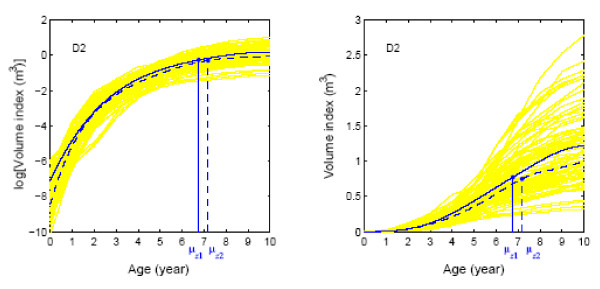
Volume growth curves for two different QTL genotypes for the QTL detected on linkage group 2 by the Legendre polynomial-based model. Left panel: log-transformed curves; Right panel: ante-transformed curves. Growth trajectories for all the individuals studied are indicated in yellow background. The effect of the detected QTL on the time to first flower is indicated.